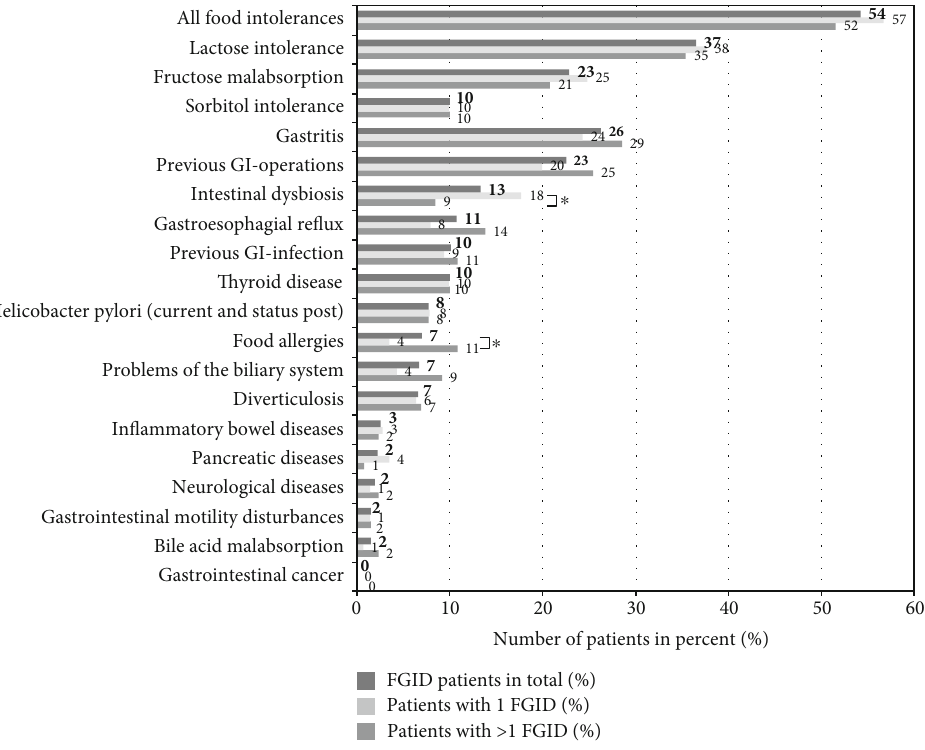
Figure 2: Somatic comorbidities in FGID patients (total FGID patients (e ff ective n = 271 ) vs. patients with 1 FGID (e ff ective n = 141 ) vs. patients with > 1 FGID (e ff ective n = 130 )); ∗ p ≤ 0 : 05